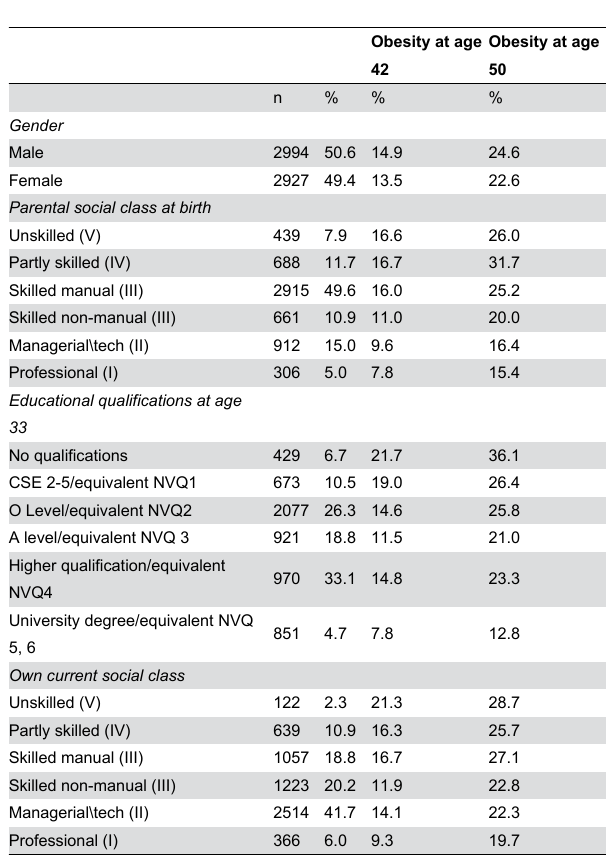
Table 1. Characteristics of the study population according to prevalence of obesity at 42 and 50